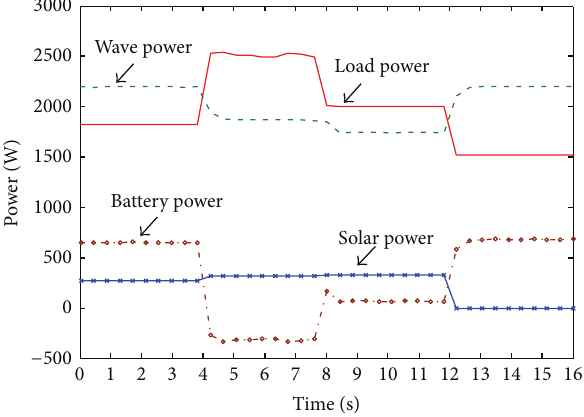
Figure 21: PV-wave hybrid system powers distribution.